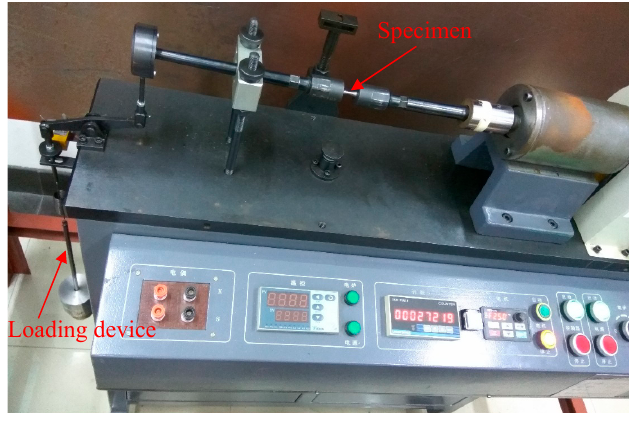
Figure 2. The testing machine.